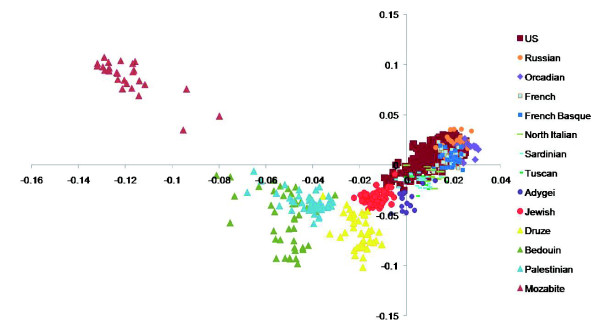
PC1 versus PC2 of Eigenstrat analysis including European and Middle Eastern subjects from the CEPH Diversity Panel. Subjects with one, two or three Jewish grandparents were excluded. Four subjects with outlying scores were excluded for better visualization of the remaining data points: a Bedouin at -0.2776,0.2012; and three Mozabites at -0.2608,0.1952; -0.2265,0.1621; -0.1611,0.1314.